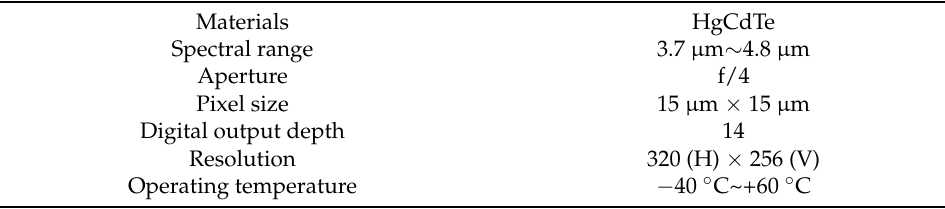
Table 1. Parameters of the cooled infrared camera.